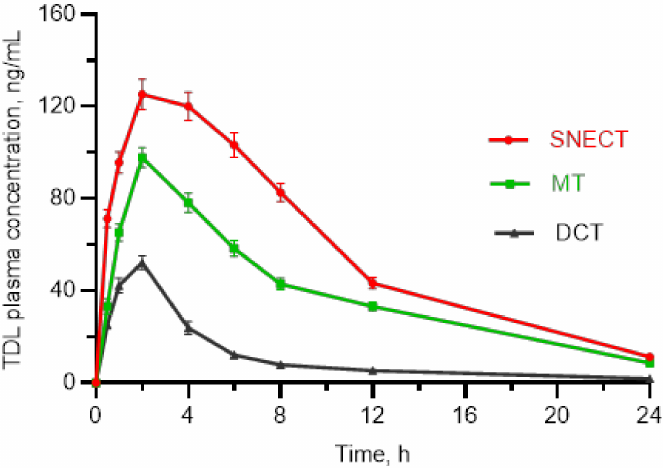
Figure 9. Rat plasma concentrations of tadalafil against time, following oral administration of tested formulations, self-nanoemulsifying chewable tablets (SNECT), marketed tablets (MT), and direct compressed tablets